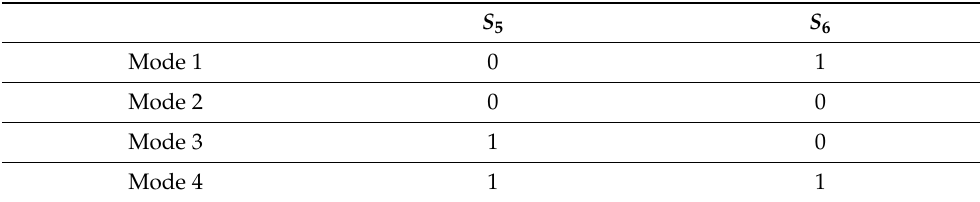
Table 9. Switching modes in the current source converter.